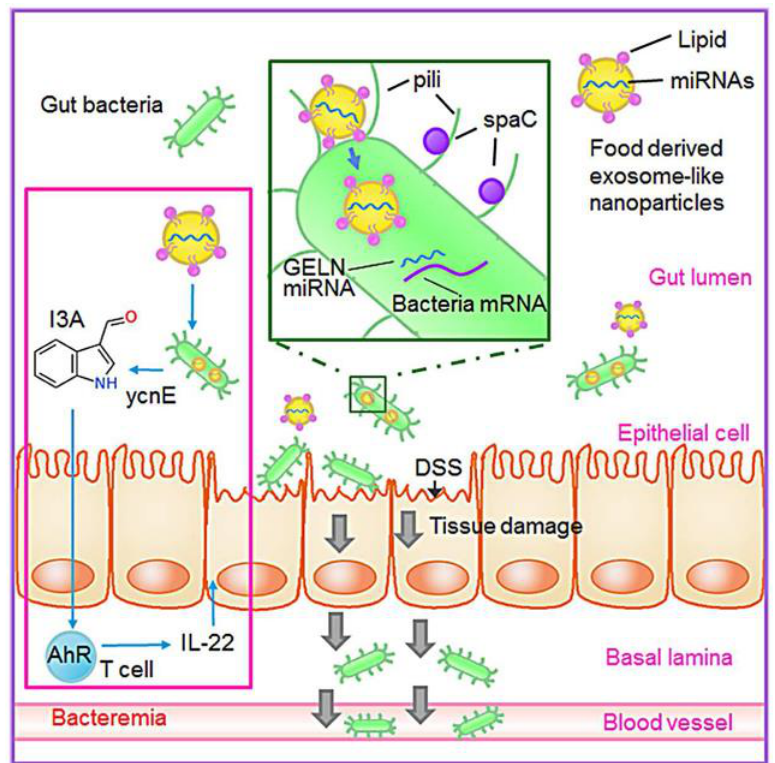
Figure 4. Ginger derived EVs shape gut microbiota and alter host physiology to Inhibit colitis. Re- produced with permission from ref. [85].